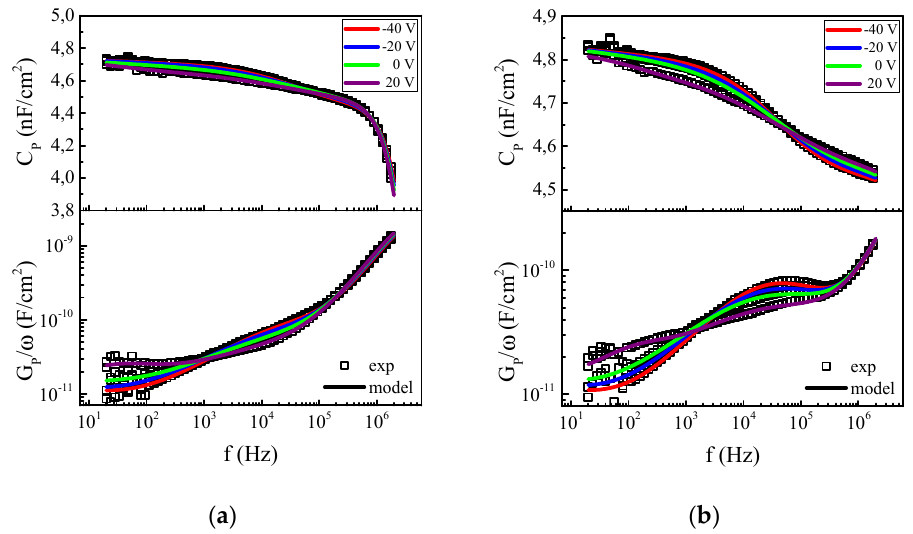
Figure 8. Admittance curves of MIS devices with ( a ) bare Au contacts and ( b ) PFBT-treated contacts. Model curves (solid lines) are superimposed on the experimental data (squared symbols). Table 3. Model parameters extracted for OTFTs in TG configuration with different contacts.